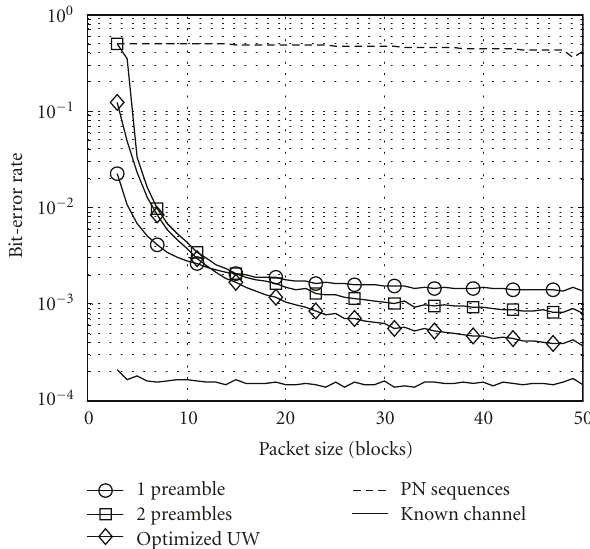
Figure 6: BER versus packet length for five di ff erent systems: “1 preamble” uses a single preamble, which supports both transmit antennas; “2 preambles” uses time-multiplexed preambles; “opti- mized UW” uses optimized UWs to estimate the channel; “PN se- quences” uses PN sequences to estimate the channel; and “known channel” has perfect knowledge of the channel state information. M = N = 2, K = 64, Q = 16, L = 15, SNR = 20dB with a rate-1/2 convolutional